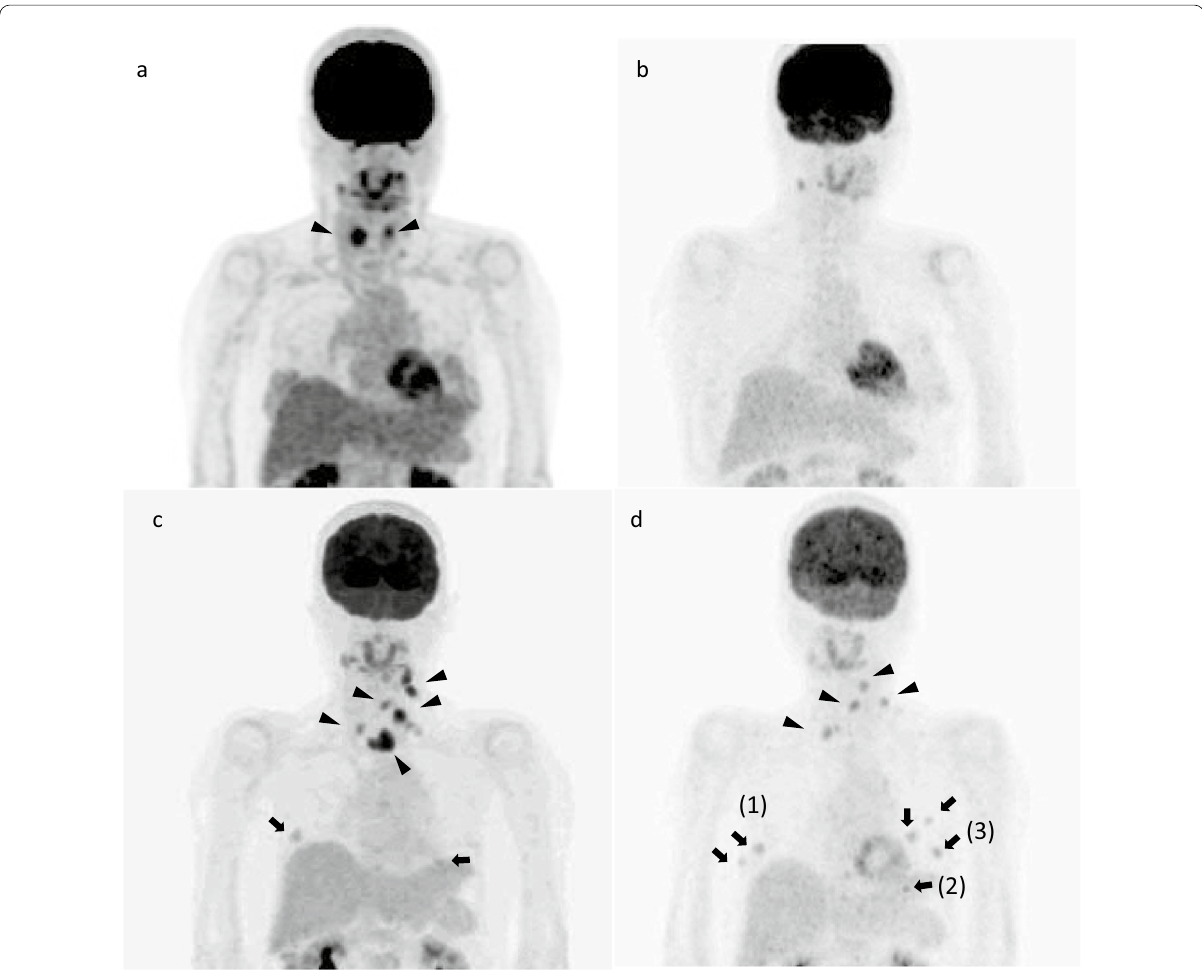
Fig. 1 FDG PET–CT findings. a PET scan performed before the first surgery. FDG accumulation in the MTC in the thyroid (arrowheads). b PET scan performed after the first surgery. No abnormal accumulation was found in the neck or the breast. c PET scan performed before the second surgery. FDG accumulation was found in the neck, mediastinum (arrow heads), and bilateral breasts (arrows). d PET scan performed after the second surgery. FDG accumulation was found in the neck (arrow heads) and breast tumors (arrows). The numbers (1) to (3) correspond to the breast tumors in the